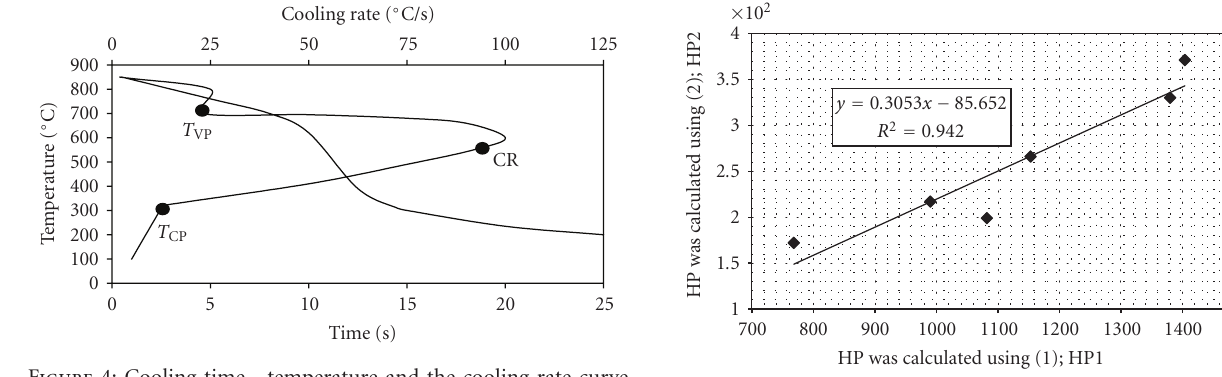
Figure 4: Cooling time—temperature and the cooling rate curve indicate transition temperatures for calculation of hardening power.